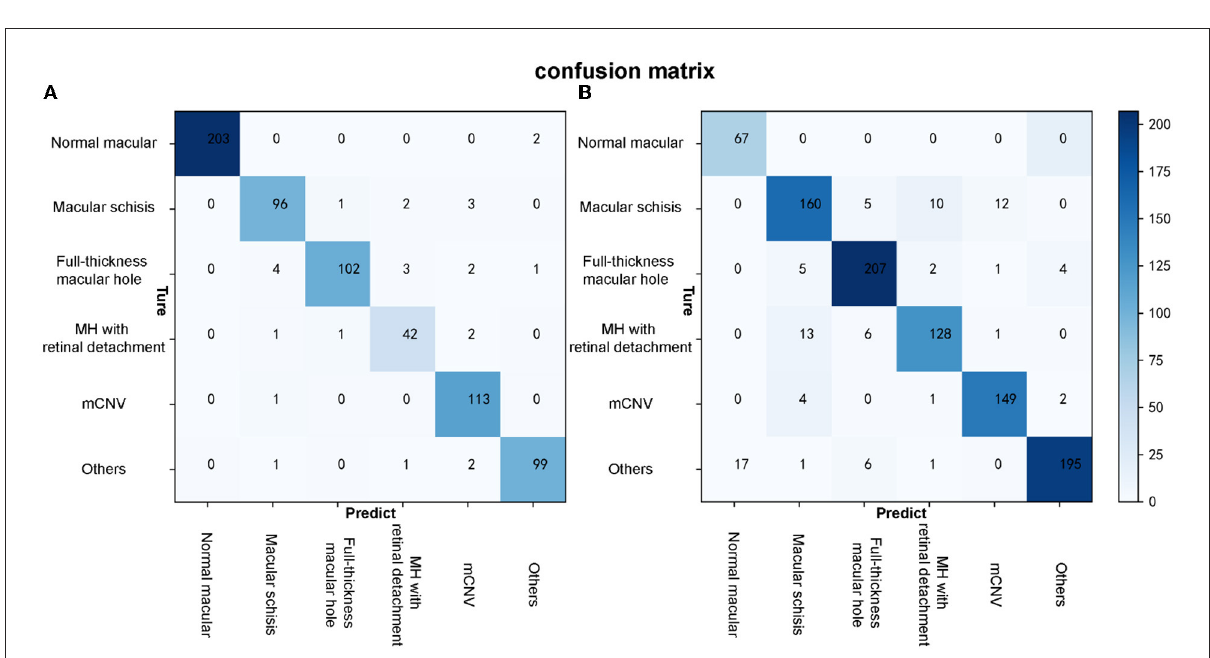
CI: 0.924, 0.959), and specificity was 98.79% (95% CI: 0.980, 0.996); the AUC for full-thickness MH was 0.962 (95% CI : 0.953, 0.971), sensitivity was 91.07% (95% CI: 0.889, 0.932), specificity